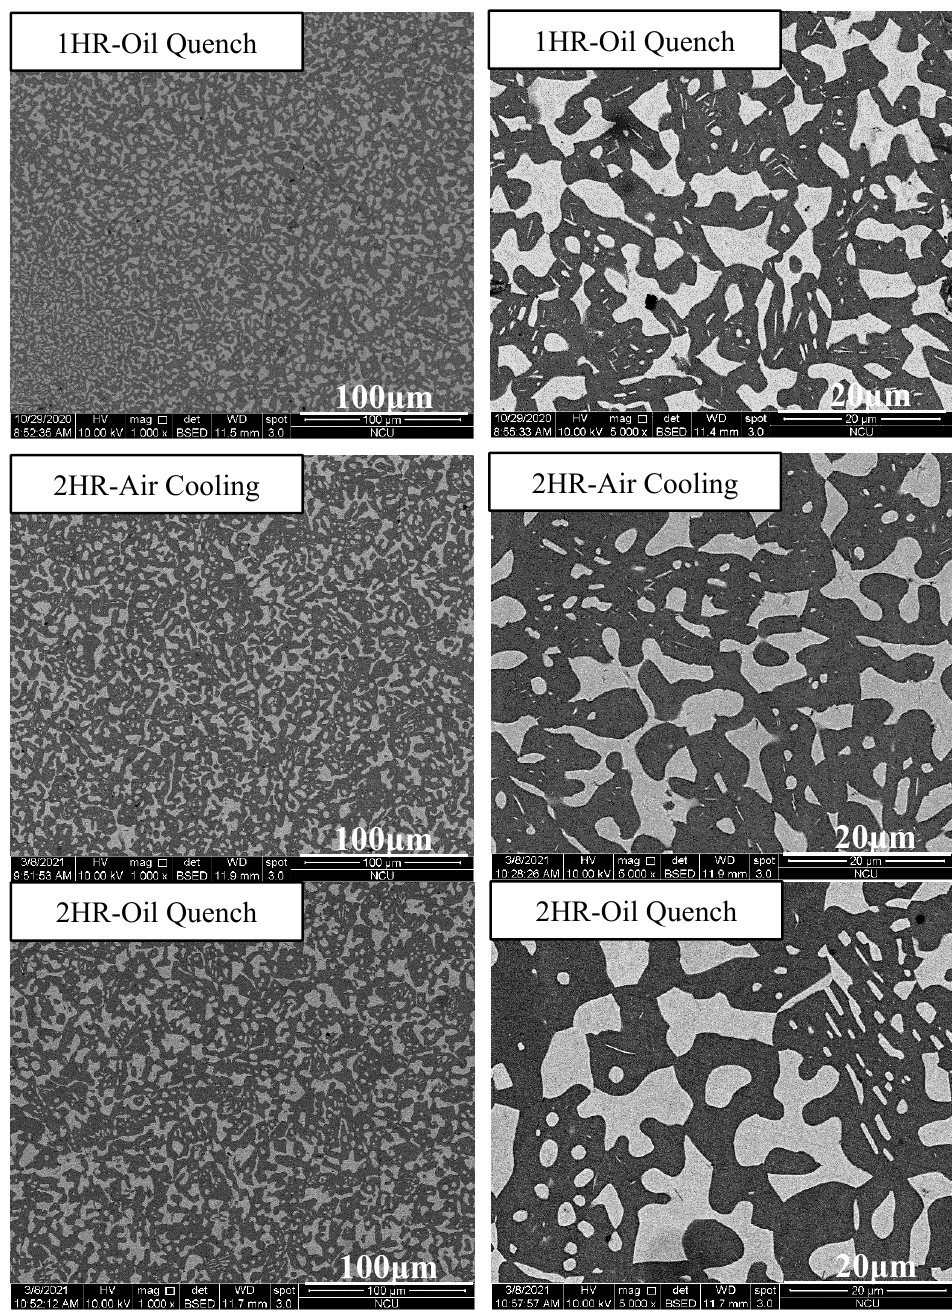
Figure 13. SEM images of the Al 50 Ti 20 Cr 10 Mn 15 V 5 MEAs annealed at 1000 °C for 0.5, 1, and 2 h, followed by air-cooling and oil-quenching.